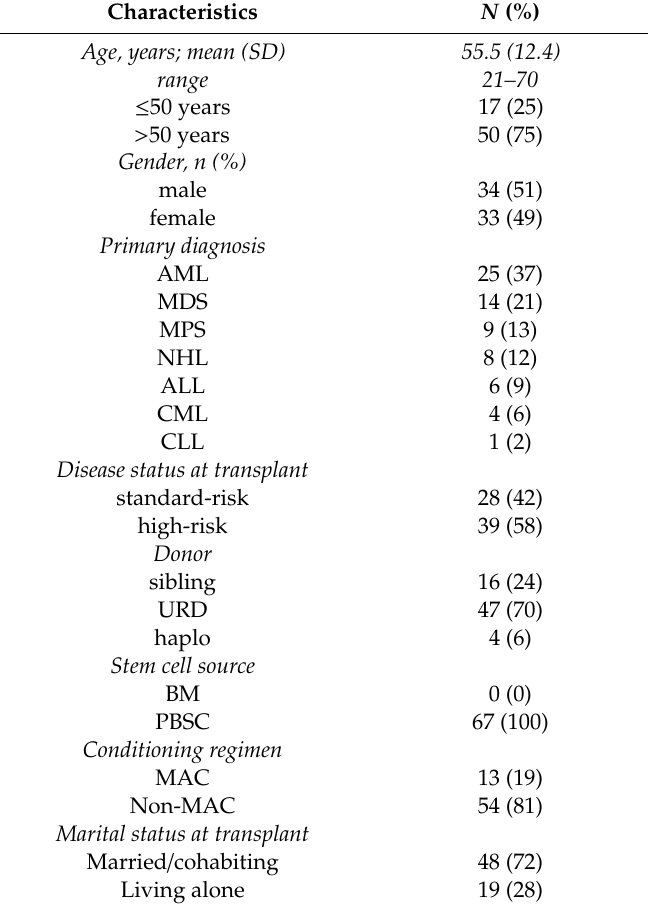
Table 1. Patient characteristics ( n =